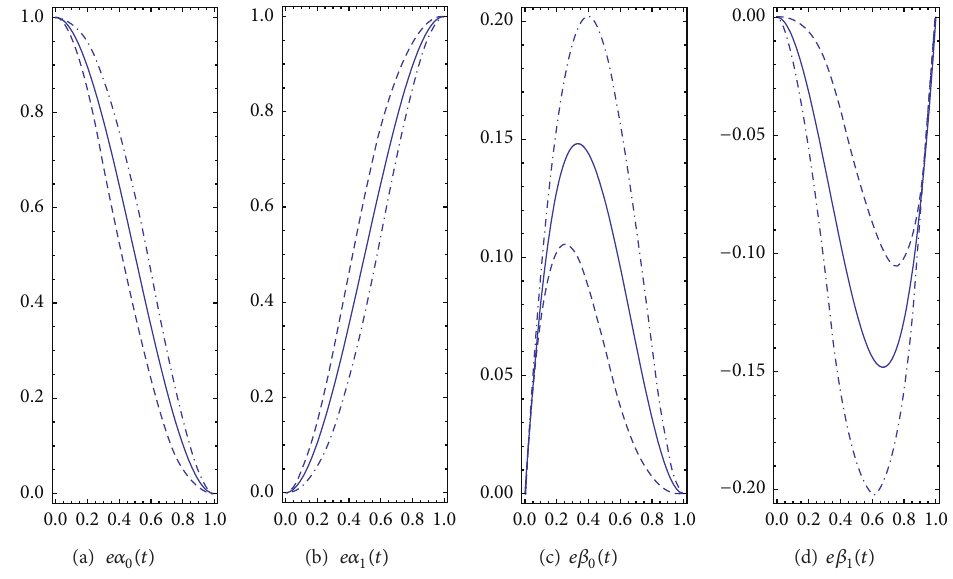
Figure 1: The graph of the four EH bases.